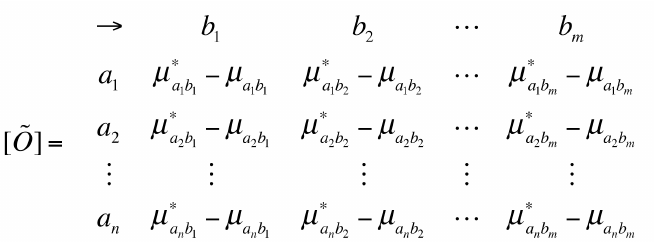
Figure 4. Forgotten effects